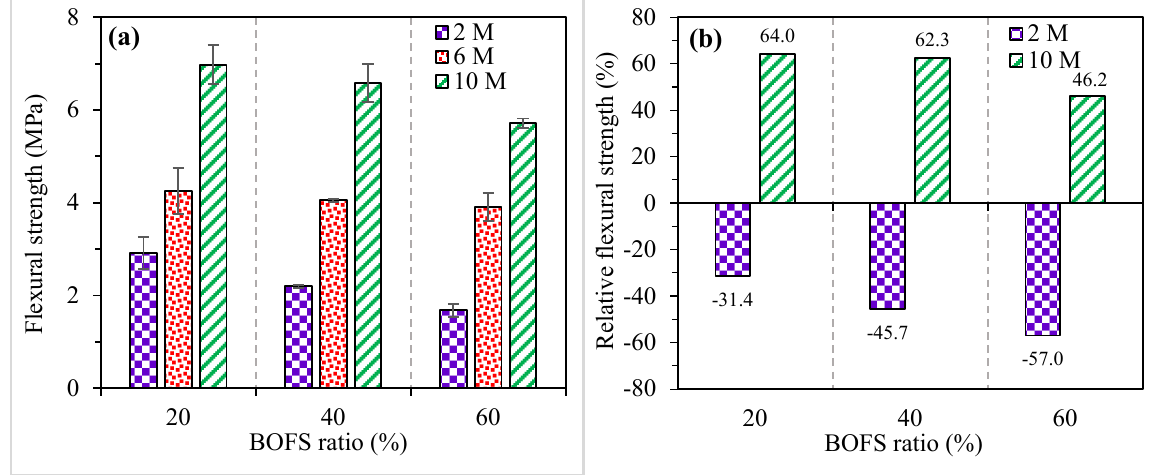
Figure 7. ( a ) Flexural strength and ( b ) relative flexural strength of specimens in comparison with 6 M. The relative flexural strength of AAM samples containing 2 and 10 M ranged between − 31.4% and − 57.4% and between 64.0% and 46.2% respectively, in comparison with